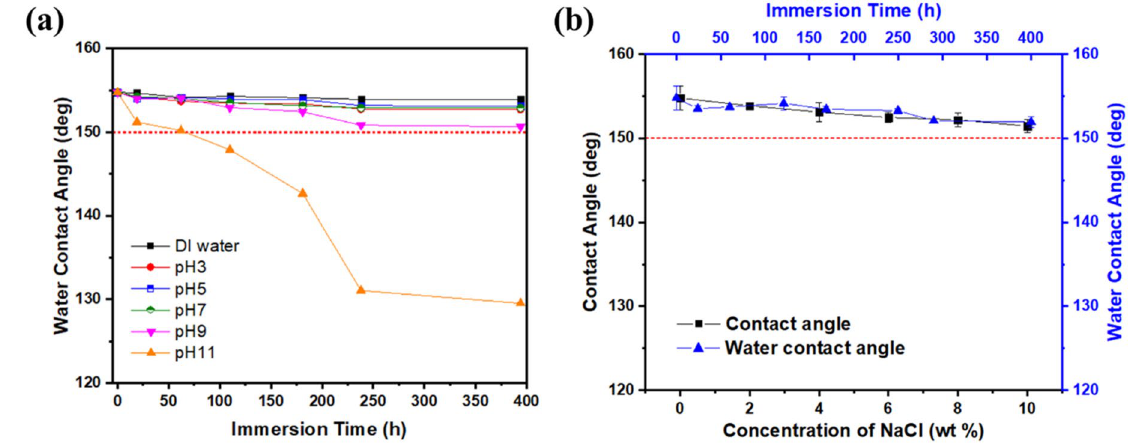
Figure 8. Influence of solutions with ( a ) different pH and ( b ) salinity on the wettability of modified (superhydrophobic) GMF